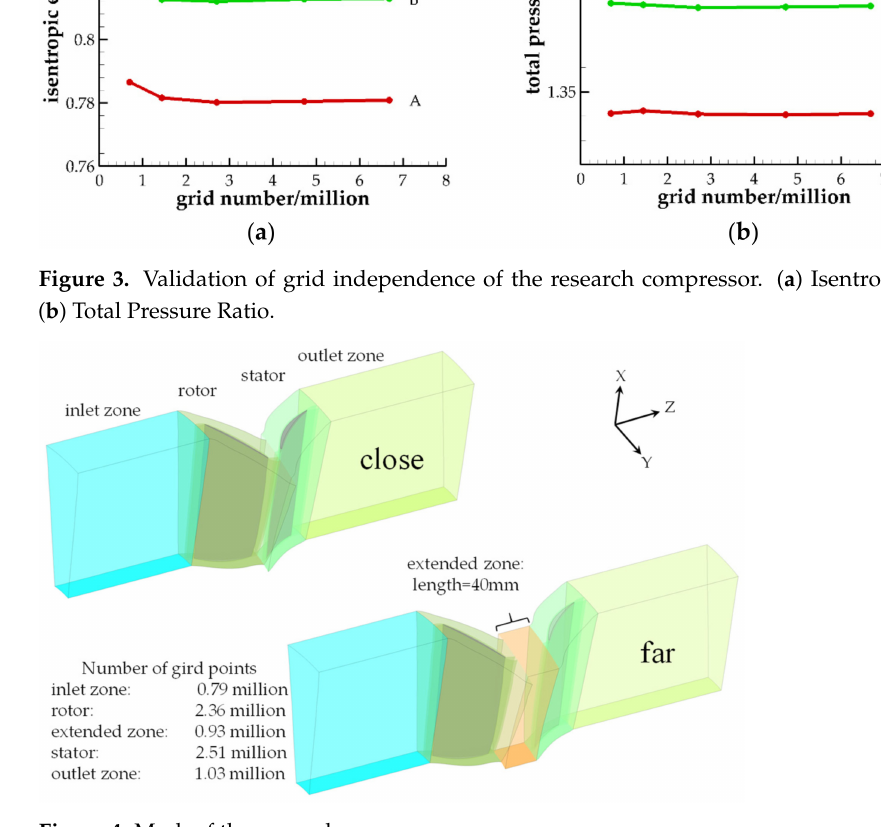
Figure 4. Mesh of the research